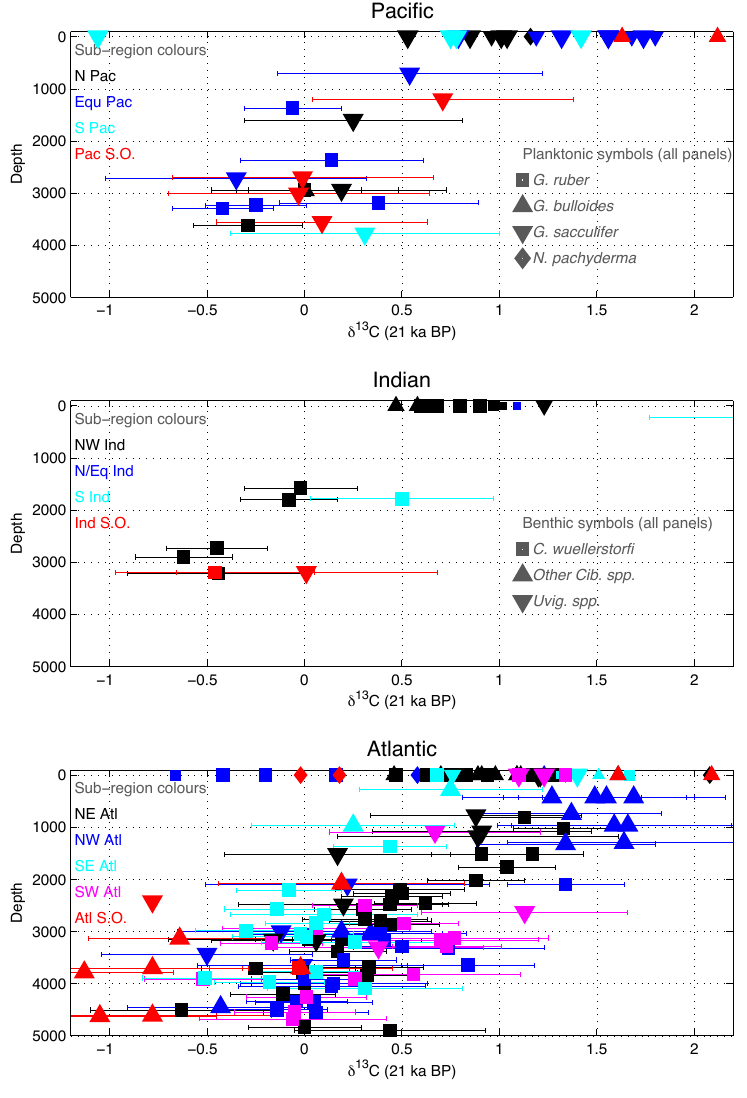
Fig. 10. 21 ka (LGM) δ 13 C time-slice, with 2 σ error bars on benthic data. δ was calculated for each core where both planktonic and ben- thic δ 13 C records were